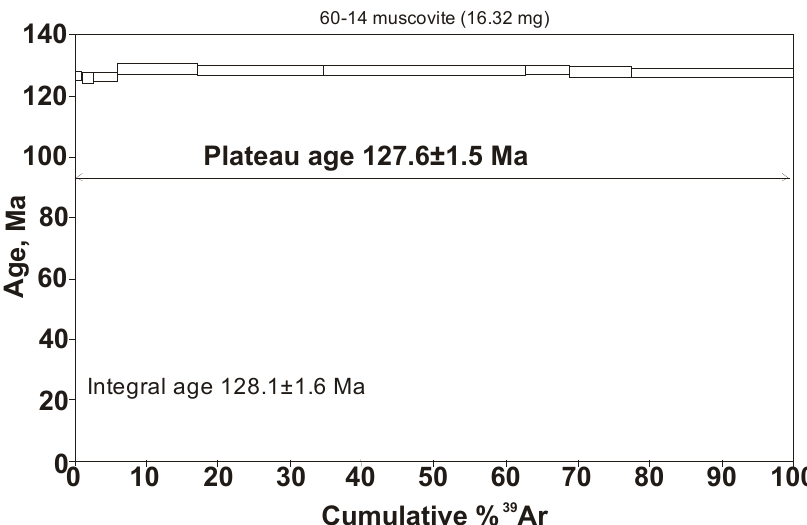
Figure 3. Concordia-Intercept age and average weighted 206 Pb/ 238 U ages corrected for common lead by the 207 Pb-method for zircons from granites of the Pervomaisky massif. 40 Ar / 39 Ar dating of muscovite from the quartz-molybdenite veinlets of the Pervomaiskoe deposit indicated the isotopic age of 127.6 ± 1.5 Ma (Figure 4).